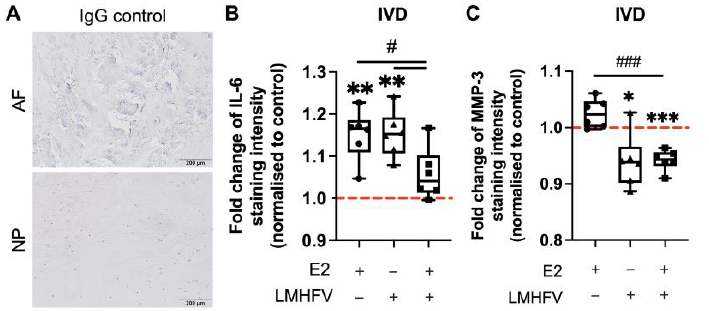
Figure A5B) and E2 + LMHFV ( p < 0.05). By contrast, MMP-3 was significantly lower in IVD tissues of E2- ( p < 0.05) and E2 + LMHFV-treated samples ( p < 0.001) compared to the control (Figure A5C). MMP-3 was also significantly lower in E2 + LMHFV-treated samples ( p < 0.001) versus E2 ( p < 0.001).